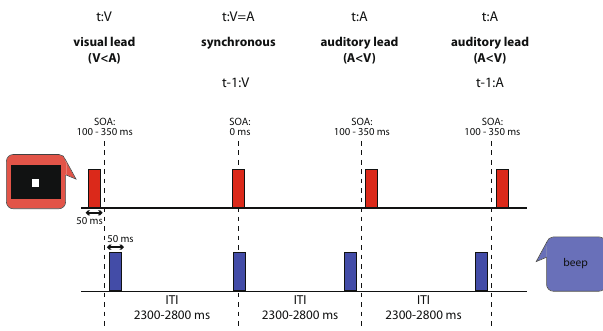
Fig. 1 Trial types and behavioral task. Time course of an example stimulus sequence used to test audiovisual synchrony judgments (illustration adapted from 2 ). The audiovisual stimulus pair was presented in one of three possible temporal con fi gurations: a visual stimulus (red) leading an auditory presentation (blue; t:V, V < A; t represents current trial), synchronous audio-visual presentation (t:V = A), and auditory leading visual (t:A, A < V). To study rapid temporal recalibration effects, we capture the context of a given trial t by indicating the type of the preceding trial (t-1) as e.g., t-1:V, as illustrated here with the synchronous presentation trial t:V = A. After each stimulus pair, the participant had to indicate by button press whether the two stimuli were synchronous or not. Seven levels of Stimulus Onset Asynchrony (SOA) were used ranging from 0 to ±350 ms. The duration of the inter-trial interval (ITI) ranged between 2300 and 2800